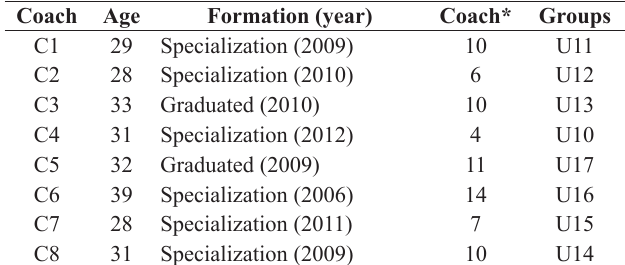
Table 1. Characterization of youth